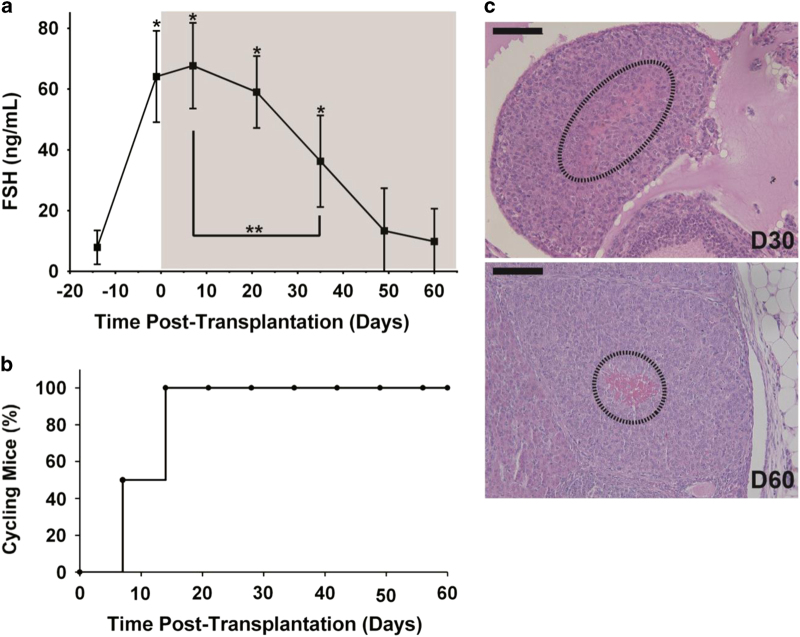
Graft function. (a) FSH level significantly increased post-OvX, confirming the complete OvX. For the group transplanted with PEG graft, FSH level decreased beginning at 35 days post-Tx (**), and FSH level declined to Pre-OvX levels by 49 days post-Tx, confirming the restoration of HPG axis. All the data are reported as mean±s.d. (with PEG graft: D-14–D28 (nmice=11), D35–D60 (nmice=6)). An asterisk (*) denoted significance within the group transplanted with PEG graft compared with pre-OvX (D-14). Statistical significance was determined by a one-way analysis of variance (ANOVA) followed by Tukey’s test (P<0.01). (b) Vaginal cytology demonstrated resumed cyclicity in 50% of mice after 7 days post-Tx and 100% by 14 days. Cyclicity was maintained up to 60 days, supporting 12–15 estrous cycles in mice. (nmice=4). (c) Corpora lutea (CL) were observed at 30 and 60 days post-Tx, in agreement with the FSH levels. CL formation suggests ovulatory events and they showed the typical characteristic of centrally located blood clot (dashed outline).